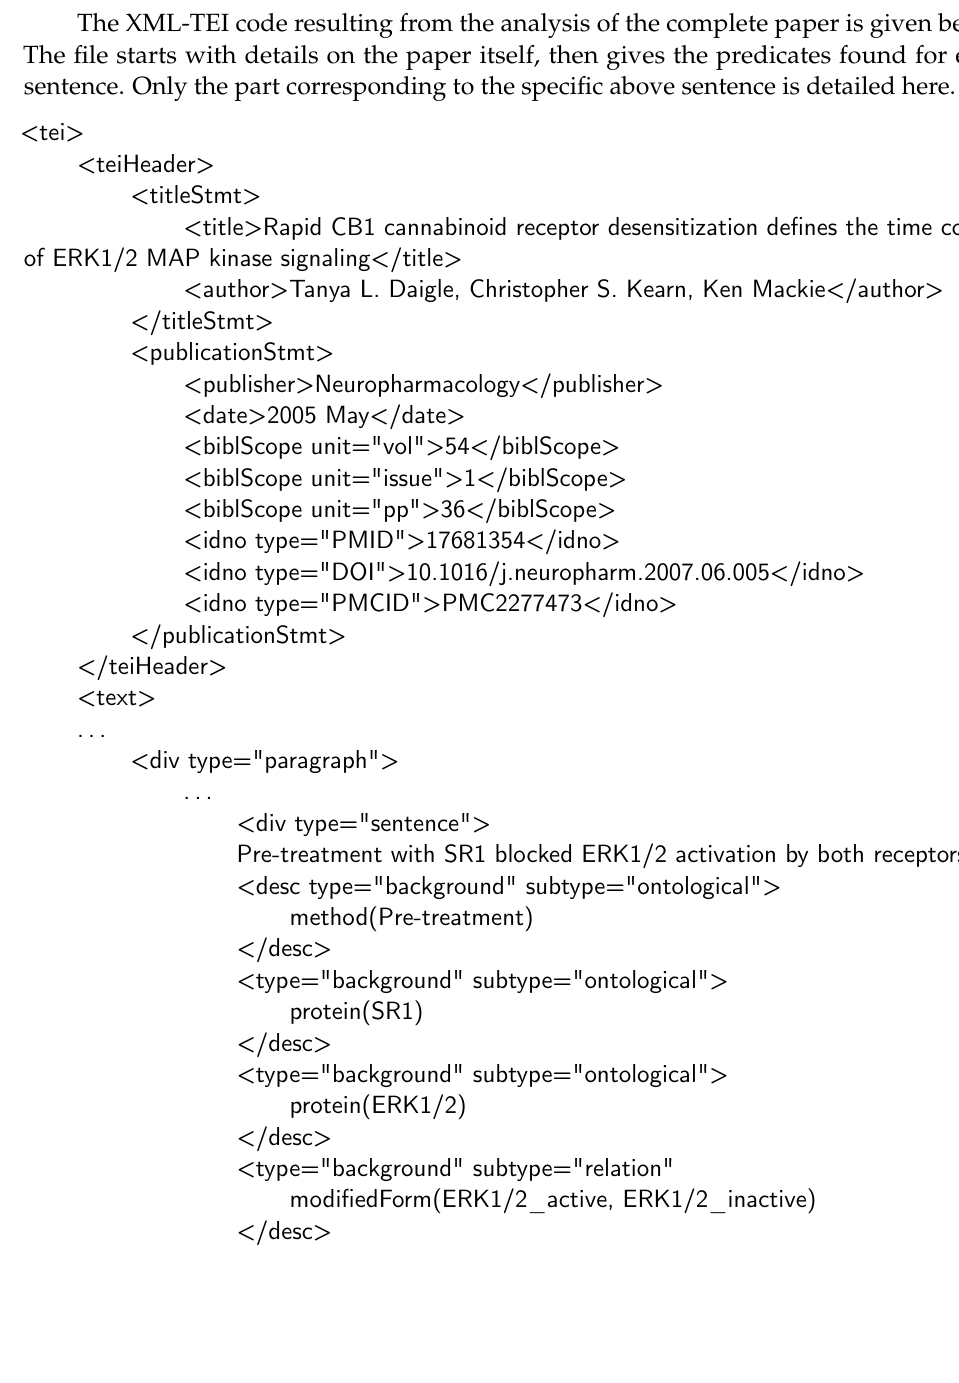
Figure 12. Pre-treatment with SR1 blocked ERK1/2 activation by both